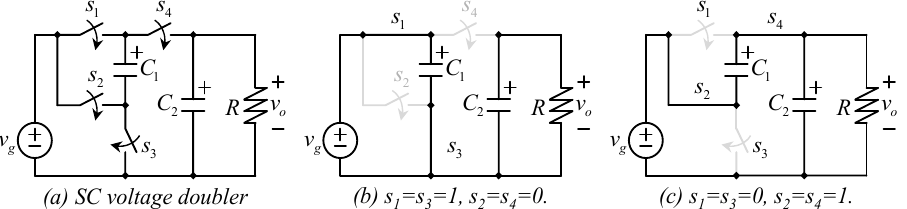
Figure 9. Switched-capacitor voltage doubler, ( a ) four switches-based topology, ( b ) equivalent circuit when switches s 1 and s 2 are on while s 2 and s 4 are off, ( c ) equivalent circuit when switches s 1 and s 2 are off while s 2 and s 4 are on.